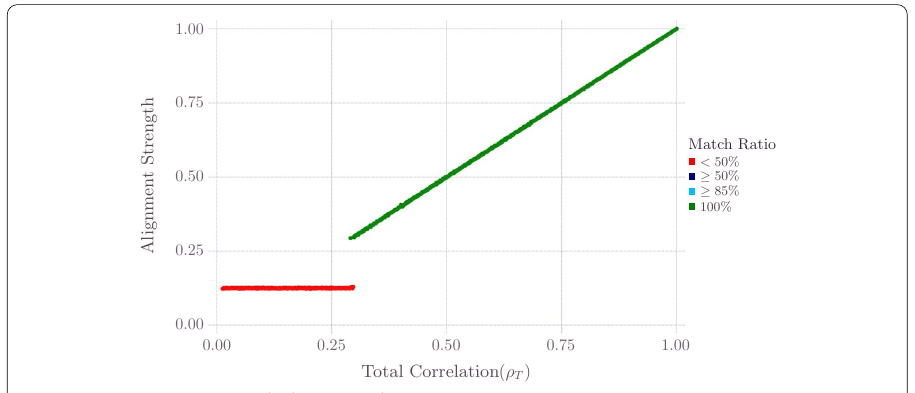
Fig. 4 Experiment A in Sect. “Block settings”; here F 1,1 , F 1,2 , F 2,2 are resp. point mass at 0.3, 0.4, 0.5